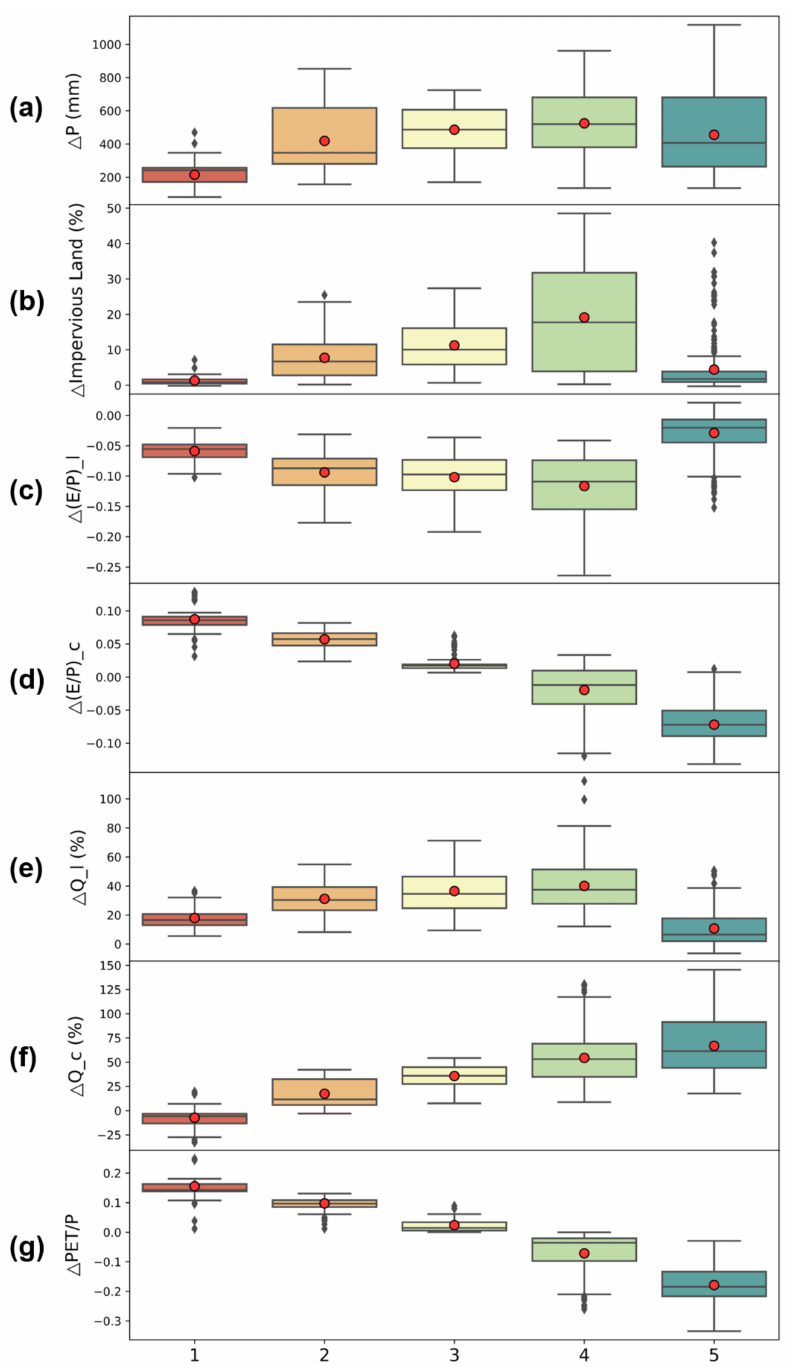
Figure 9. Boxplots showing the patterns of change in ( a ) precipitation, ( b ) impervious land (%), ( c ) evaporation index by land use change, ( d ) evaporation index by climate change, ( e ) runoff by land use change (%), ( f ) runoff by climate change (%), ( g ) aridity index for each